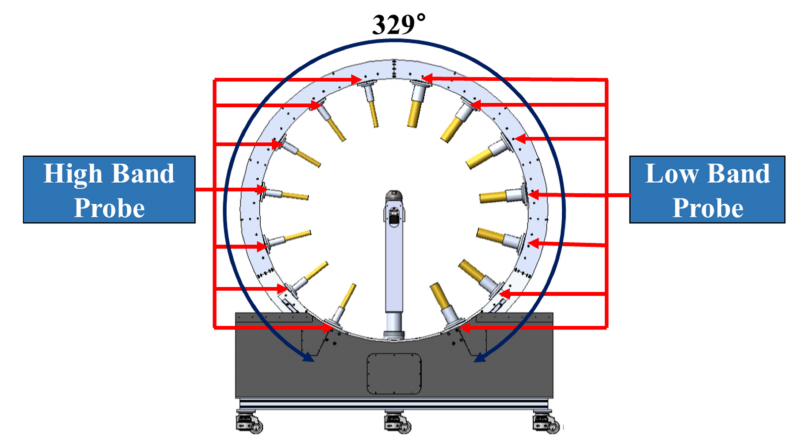
Figure 3. Multiple Probe Placement.